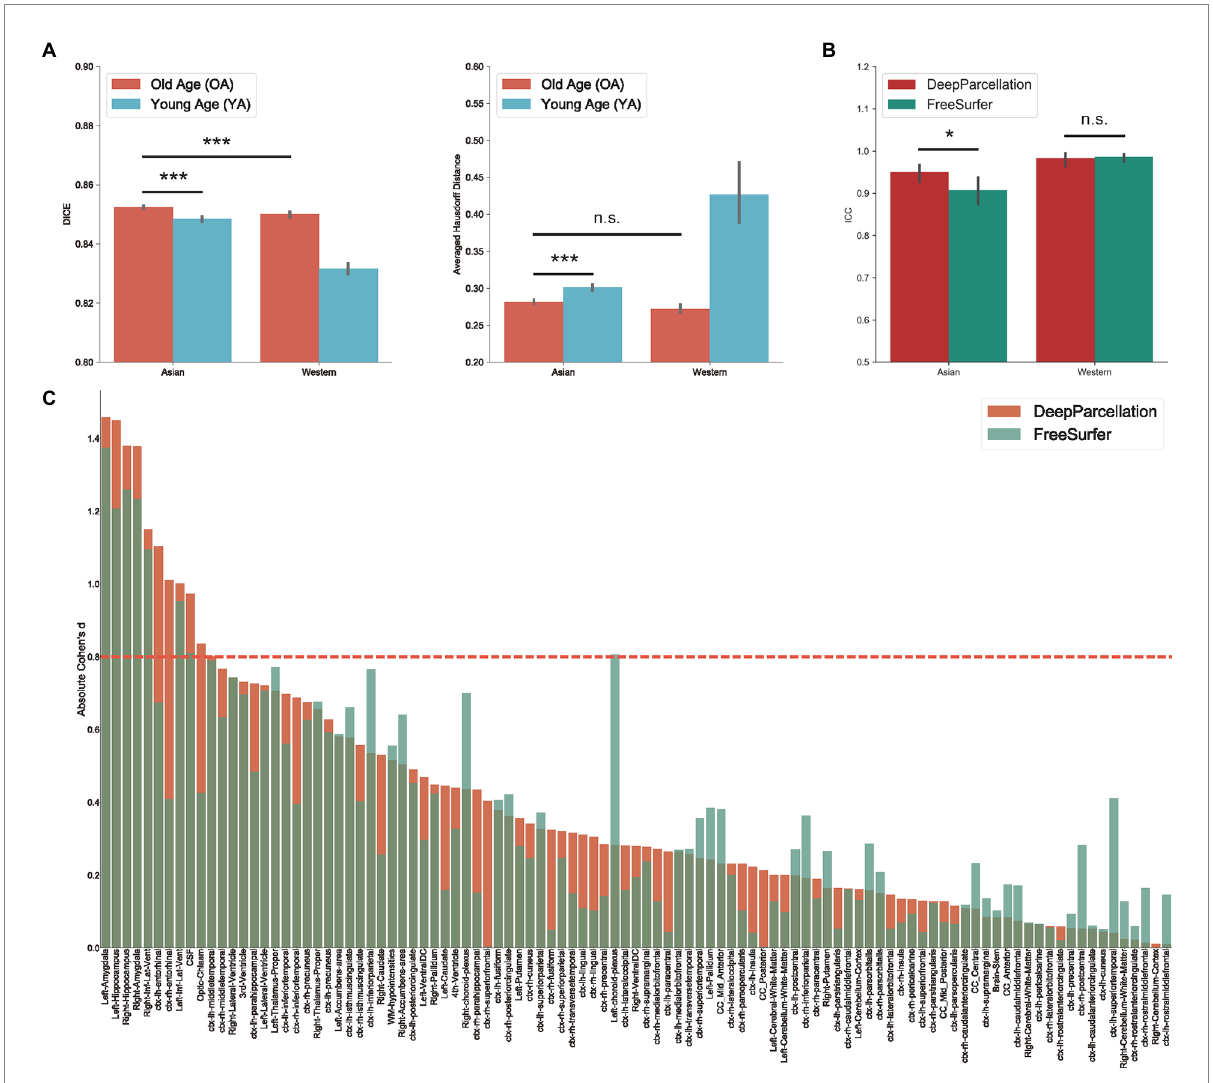
FIGURE 3 Evaluation of DeepParcellation. (A) Similarity evaluation among various age and ethnicity groups. Dice coefficient (DICE) and aHD comparison between groups. Brains of older Asian individuals showed significantly higher DICE values compared with brains of young Asian individuals and older Caucasian individuals. Brains of older Asian individuals also showed significantly higher averaged Hausdorff Distance values compared with brains of young Asian individuals. (B) Intra-subject reliability evaluation between DeepParcellation and FreeSurfer across ethnicities. DeepParcellation showed a significantly higher intra-class correlation coefficient than FreeSurfer in brains of Asians. (C) Between-group variability evaluation using Cohen’s ds between DeepParcellation and FreeSurfer across parcellated regions of interest. The red dashed line indicates a Cohen’s d of 0.8 (large effect size). n.s. not significant; * significant at p < 0.05; ** significant at p < 0.01; *** significant at p <